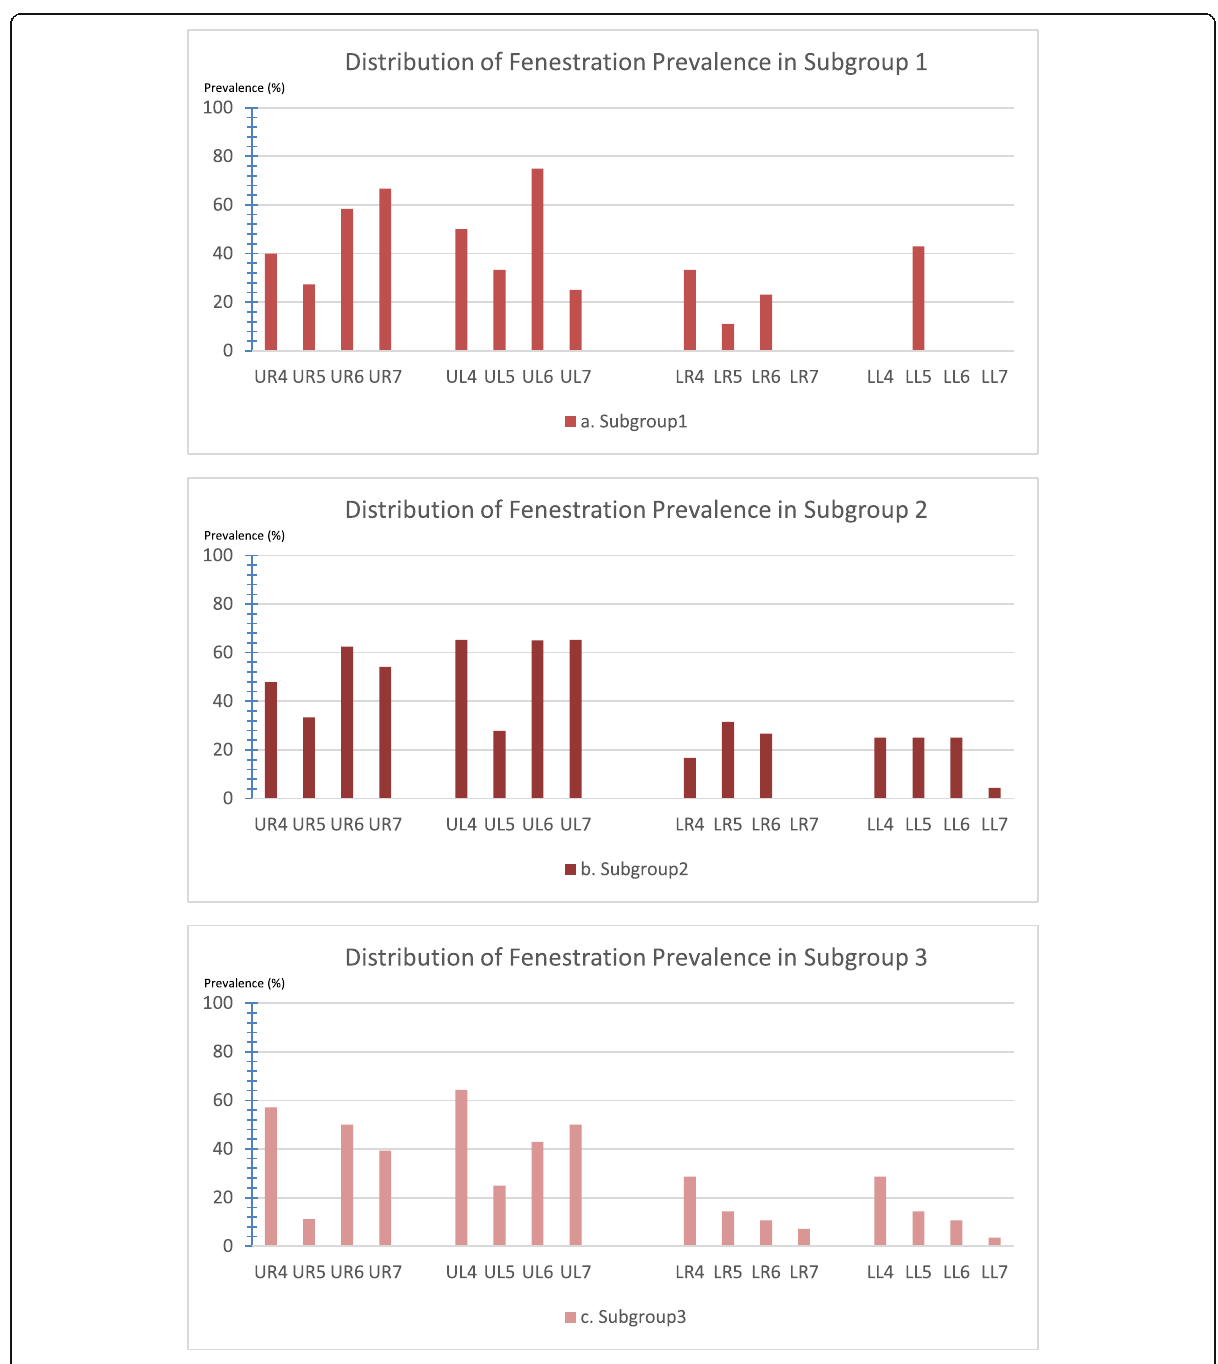
Fig. 3 Distribution of the fenestration prevalence among the posterior teeth by subgroup. a Subgroup 1, the crossbite teeth in the study group. b Subgroup 2, the noncrossbite teeth in the study group. c Subgroup 3, the noncrossbite teeth in the comparison